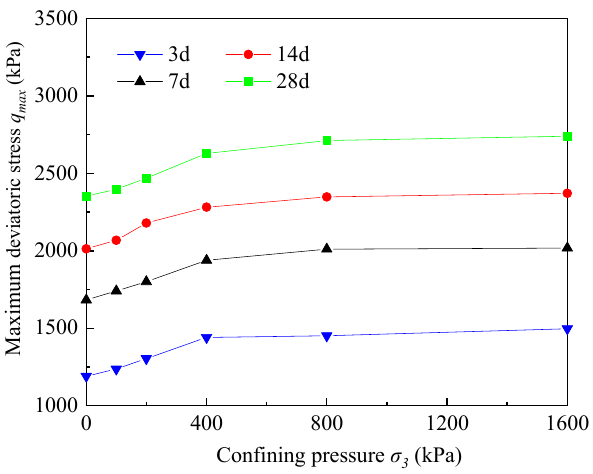
Figure 11. Correlation between the maximum deviatoric stress and confining pressure (cement content: 18%).